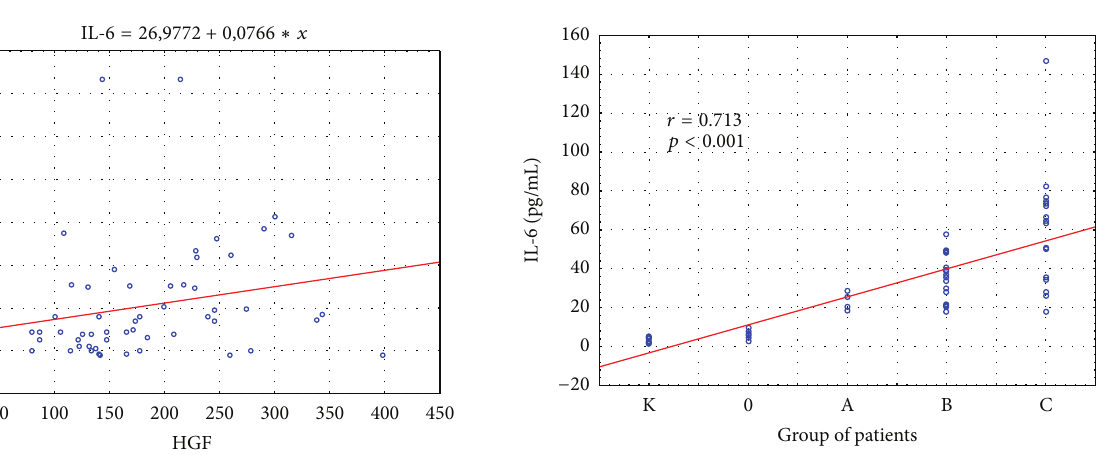
Figure 7: Relationships between IL-6 and stage of liver cirrhosis. Key: 0: alcoholics without liver cirrhosis; A, B, and C: alcoholics with liver cirrhosis Pugh-Child stages A–C; K: healthy controls.